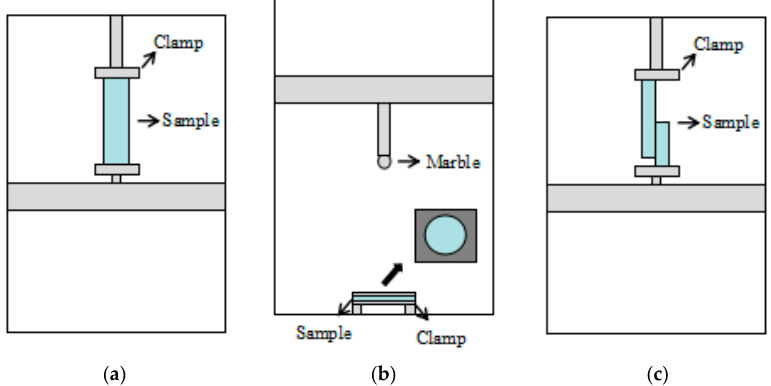
Figure 3. Schematic presentation of experimental tests ( a ) tensile test; ( b ) bursting test; ( c ) tearing test.